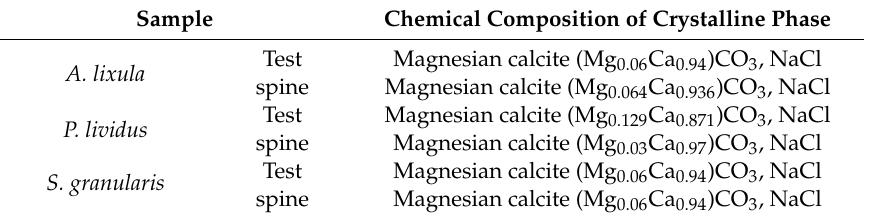
Table 3. Data of an X-ray powder di ff raction of tests and spines of the three species.